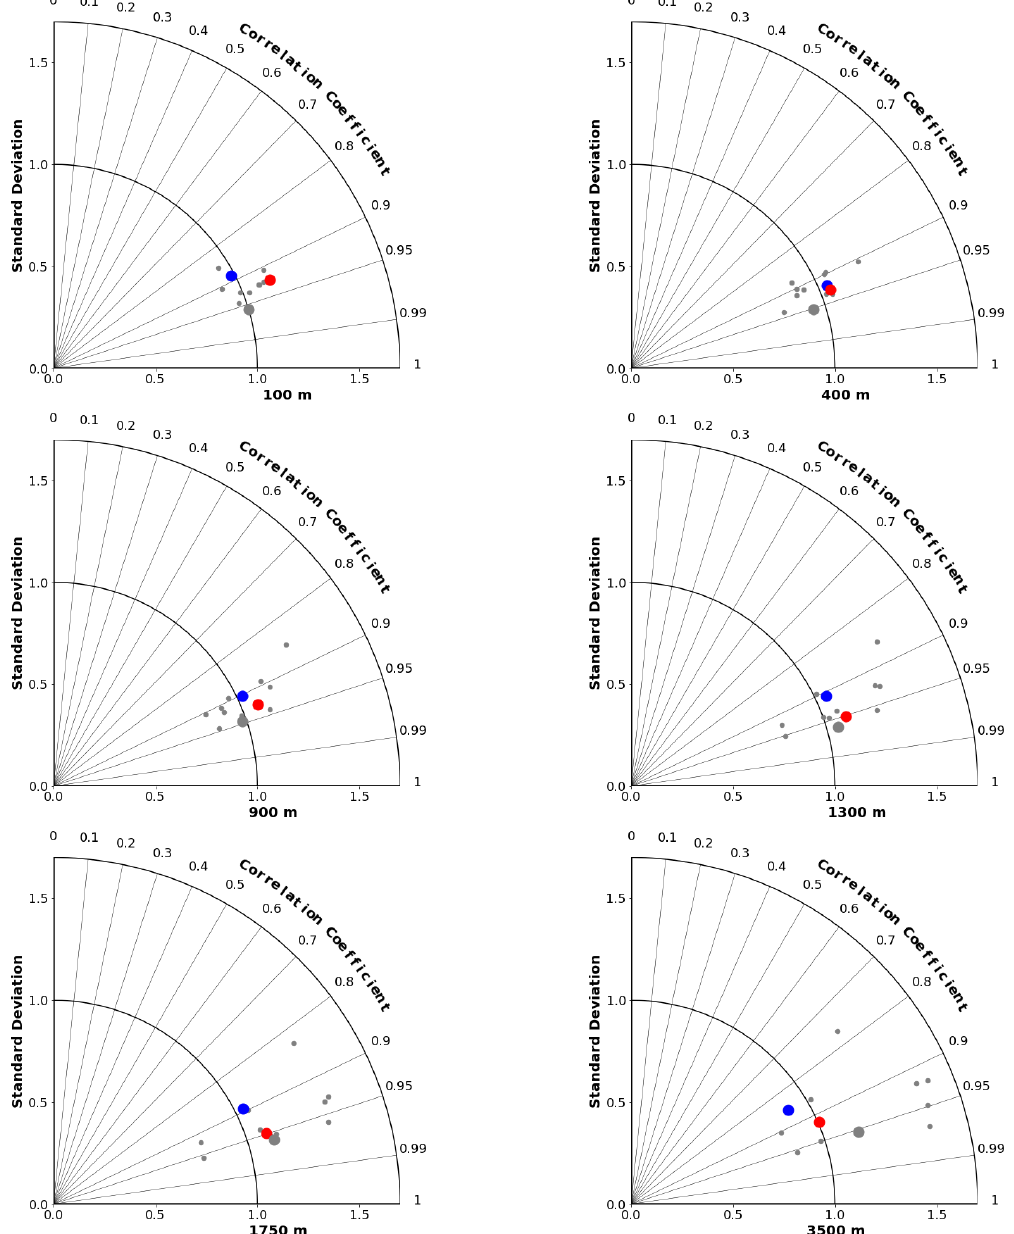
Figure 4. Taylor diagrams (Taylor, 2001) comparing modelled and observed distributions of oxygen at specific depths from 100 to 3500m. The angle from the vertical indicates spatial pattern correlation. Distance from the origin indicates ratio of standard deviation in modelled vs. observed (WOA2018) fields. Red dots represent CanESM5-CanOE, blue dots CanESM5, small grey dots other CMIP6 models, and large grey dots the model ensemble mean for all CMIP6 models except CanESM5 and